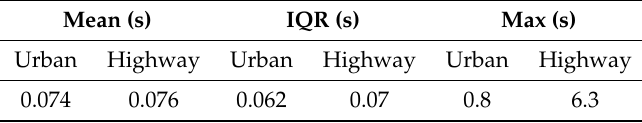
Table 1. Statistics of V2V RTT values. IQR: interquartile